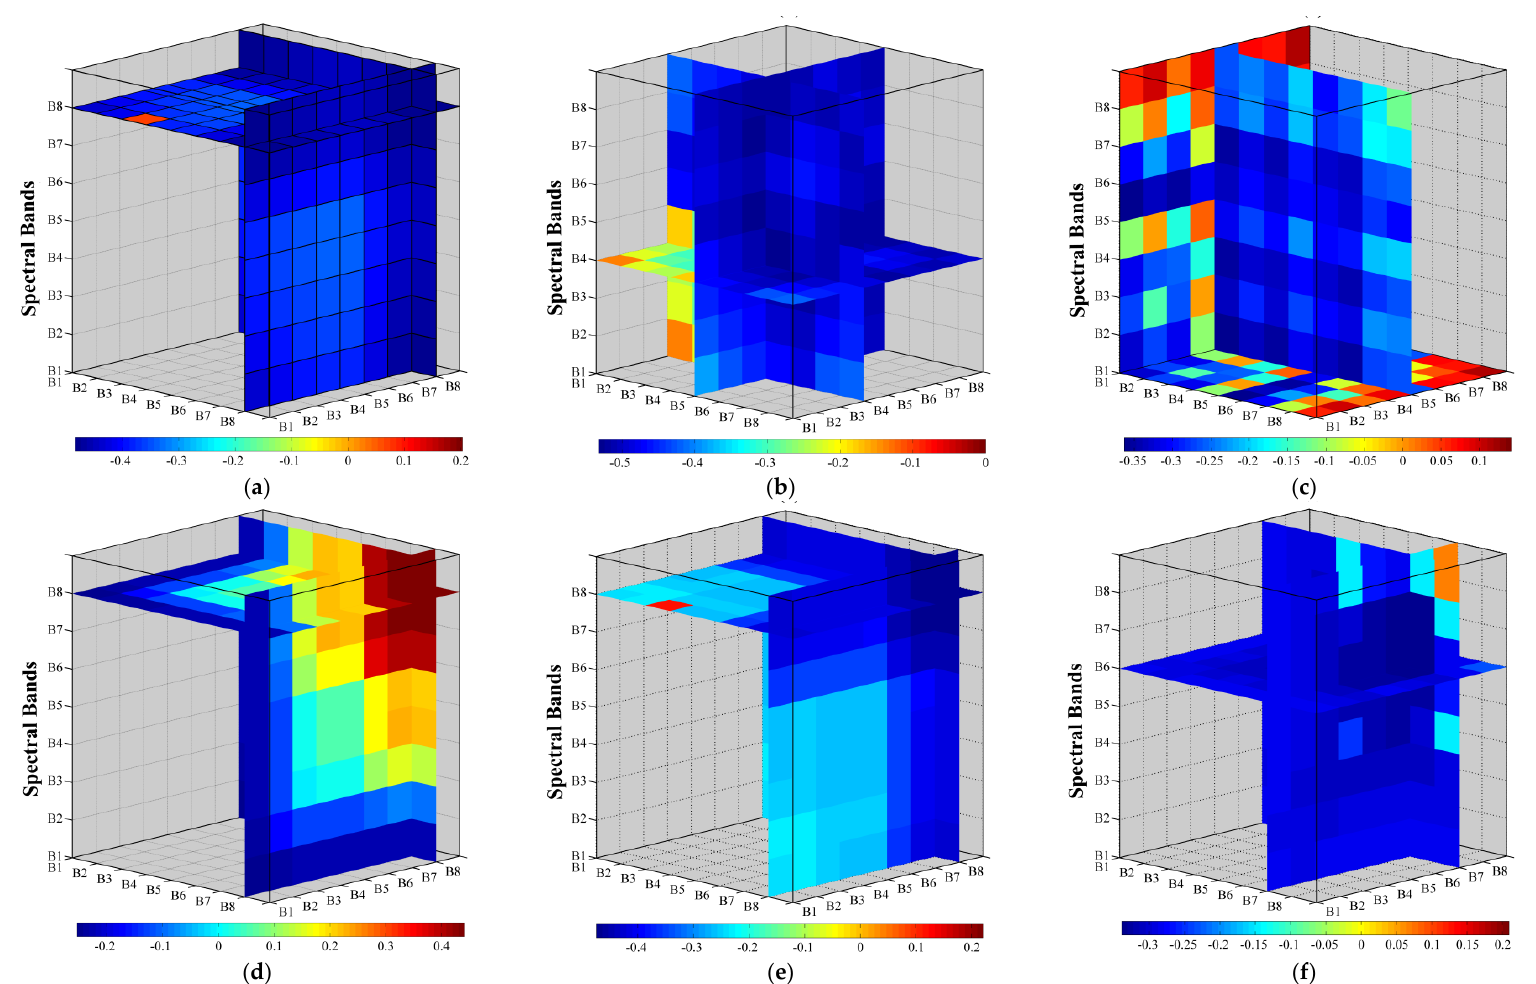
Figure 12. The correlation analysis between EC and optimized spectral indices based on reciprocal first derivative. ( a ) - ( f ) represent the correlation EC with SI2, respectively.